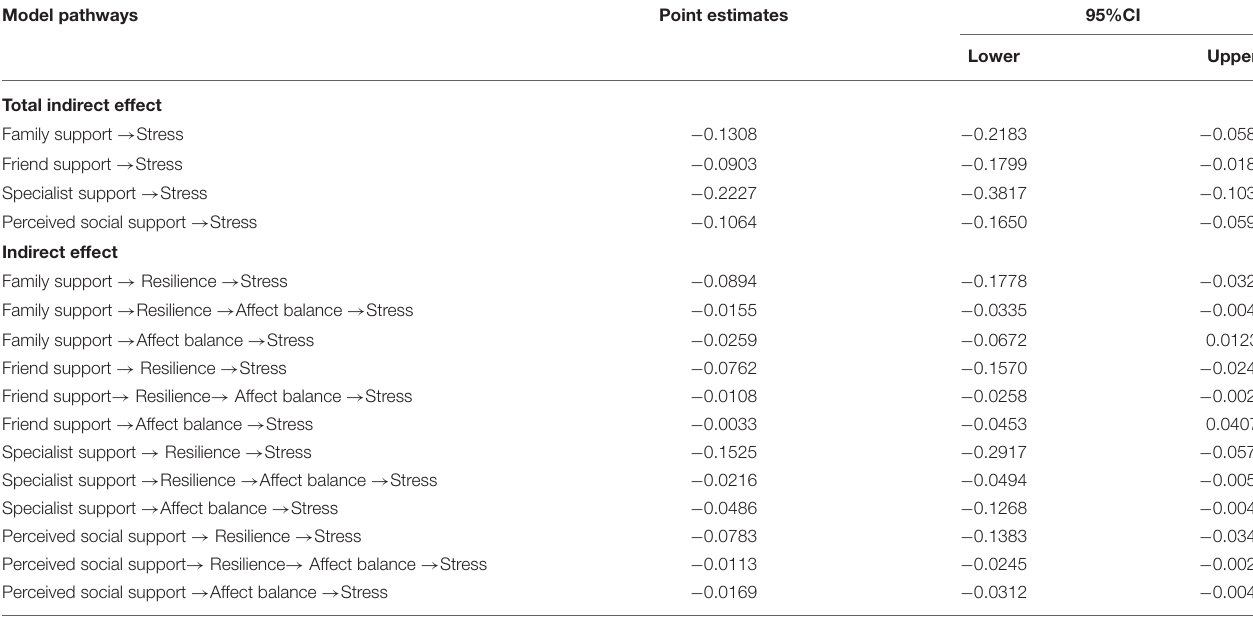
TABLE 3 | Bootstrapping indirect effects and 95% confidence intervals (CI) for the final mediation model. Model pathways